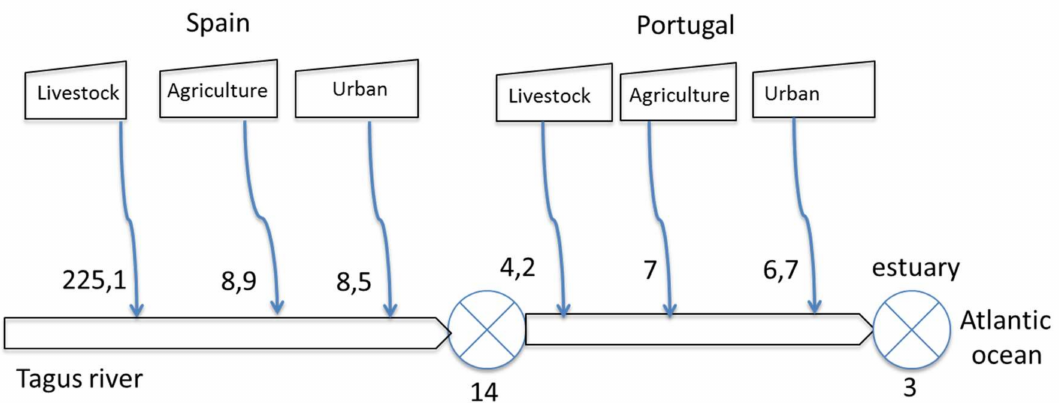
Figure 4. Estimated potential N loads (kt y − 1 ) into Tagus River Basin surface waters per sector (livestock, agriculture, and urban), pressure at the Spain/Portugal border, and the discharge at the Tagus River estuary, in Atlantic Ocean for 2009–2015